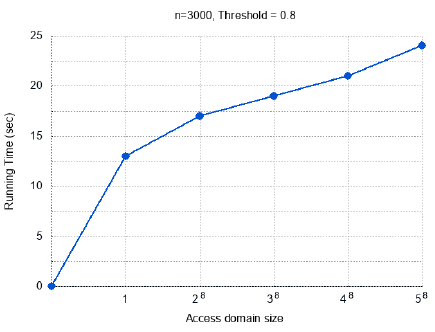
Figure 5. Running time vs. Access Domain Figure 6. Running time vs.